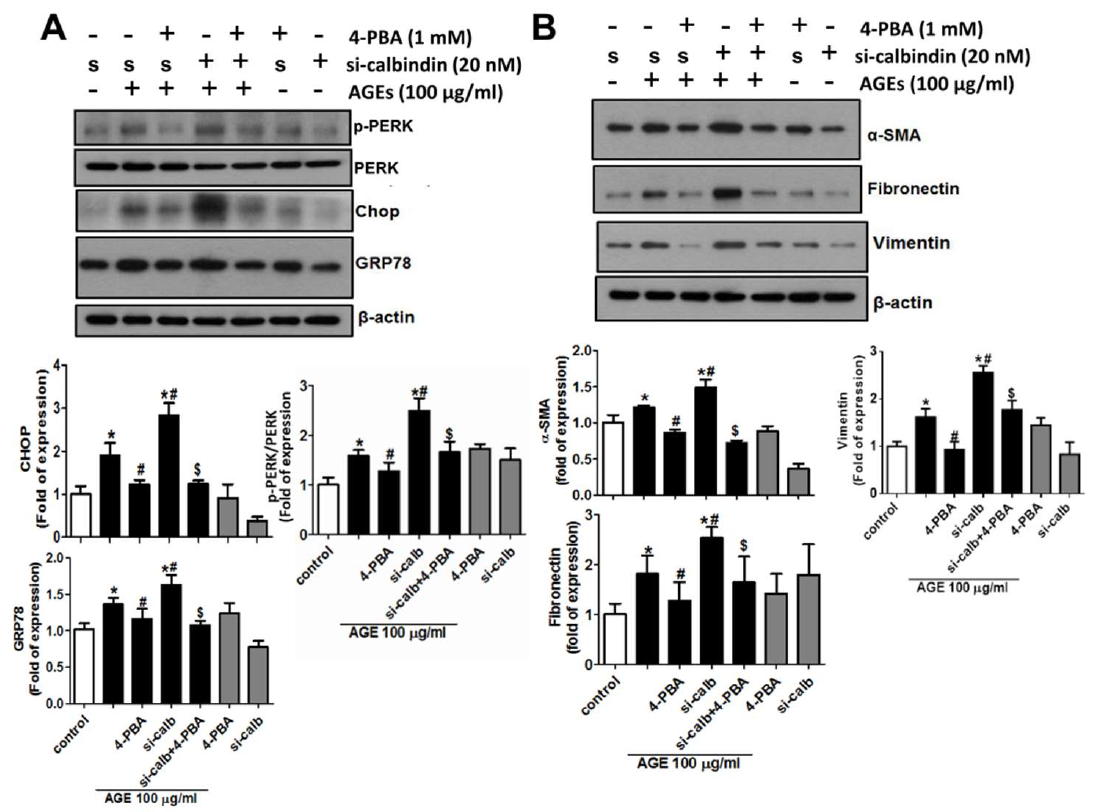
Figure 6. 4-PBA counteracted AGEs-induced and calbindin-D28k silencing-enhanced ER stress and fibrotic signals in HK2 cells. Cells were transfected with scramble (s or control; 40 nM) or calbindin-D28k siRNA (si-calbindin or si-calb; 40 nM) for 6 h. Transfected cells were treated with 4-PBA (1 mM) for 1 h, and then treated with AGEs (100 μg/mL) for 48 h. Protein expressions of CHOP, GRP78 and PERK ( A ) and α-SMA and fibronectin and vimentin ( B ) in HK-2 cells were determined by Western blotting. Protein levels were quantified by densitometry and normalized by β-actin levels. Data are presented as means ± SEM (n = 5). * P < 0.05, vs. control or scramble control group. # P < 0.05, vs. AGEs + scramble group. $ P < 0.05, vs. AGEs + calbindin-D28k siRNA group.